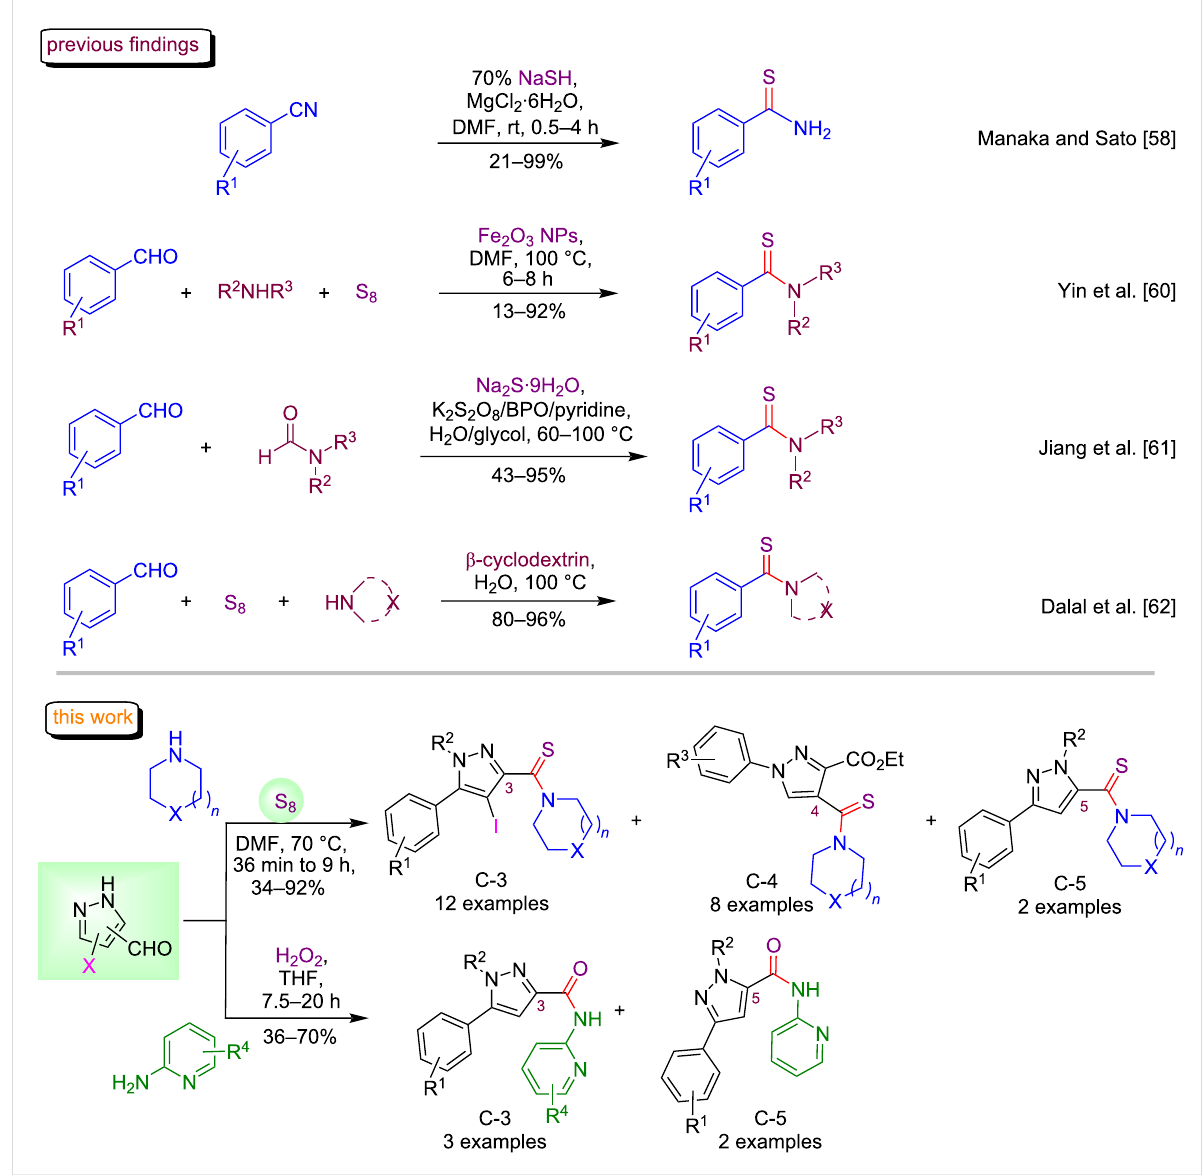
Figure 2: Previous and present findings for the synthesis of thioamide derivatives.